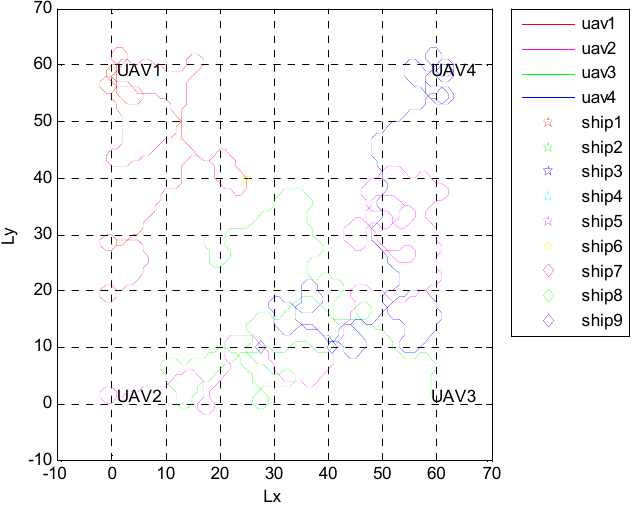
Figure 5. Random search result.